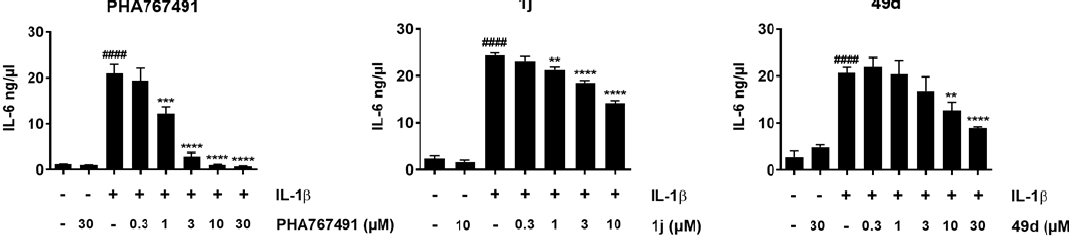
Figure 5. Inhibition of IL-6 production by reference compound PHA767491 , 1j (cytotoxic at 30 µ M) and 49d in inflammatory conditions. Blocks are means and bars are SEM values ( n = 4). ** p < 0.01, *** p < 0.001, **** p < 0.0001 compared to the control IL-1 β group. #### p < 0.0001 compared to the non-stimulated